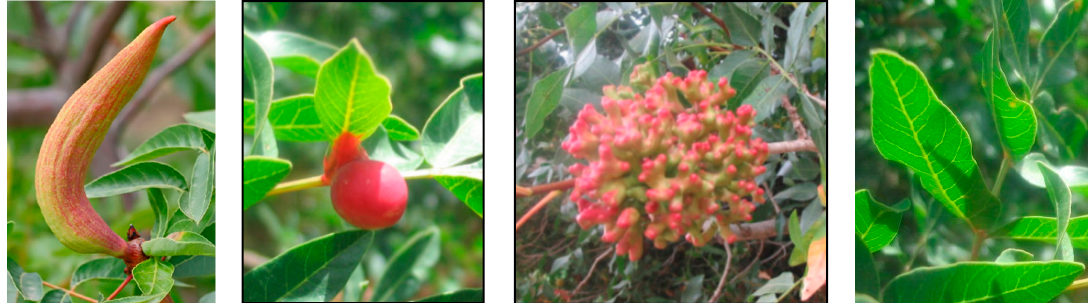
Figure 1. Pistacia galls—Left to right, B. pistaciae *, Geocia sp., S. wertheimae . P. atlantica leaf * (image courtesy of ©entomart via Wikimedia